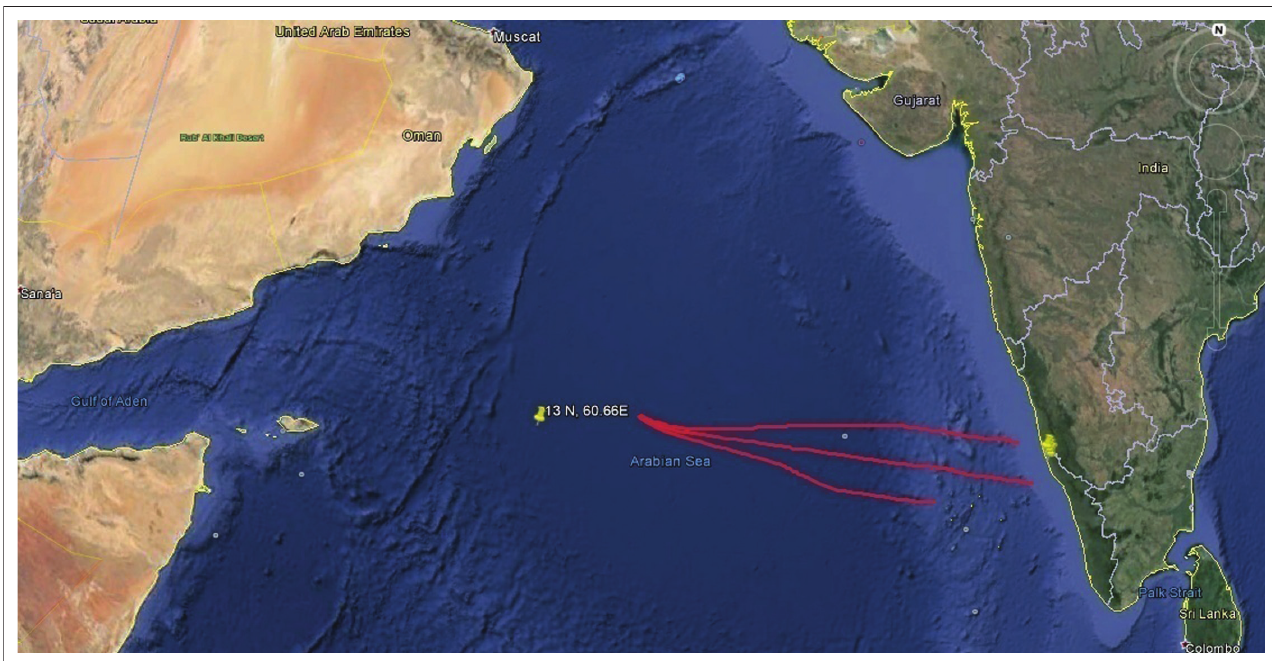
FIGURE 2: Ship accident location in Arabian Sea. Stranded containers moved to the western coast of India and washed ashore in Kasargod coast, Kerala, India.